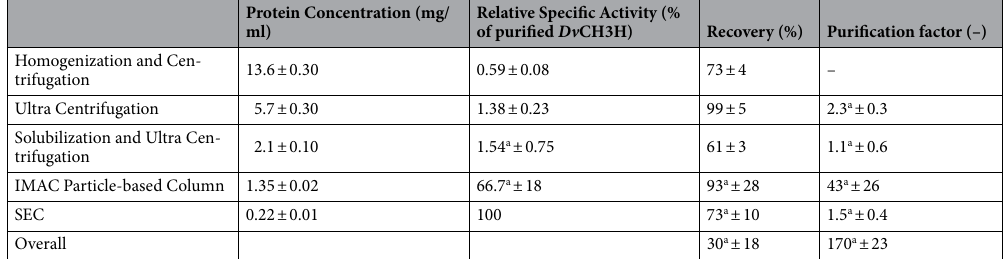
Table 3. Overview of the purification process. a Theoretical values were calculated from indirect measurements, as indicated in the text, because direct measurements were not